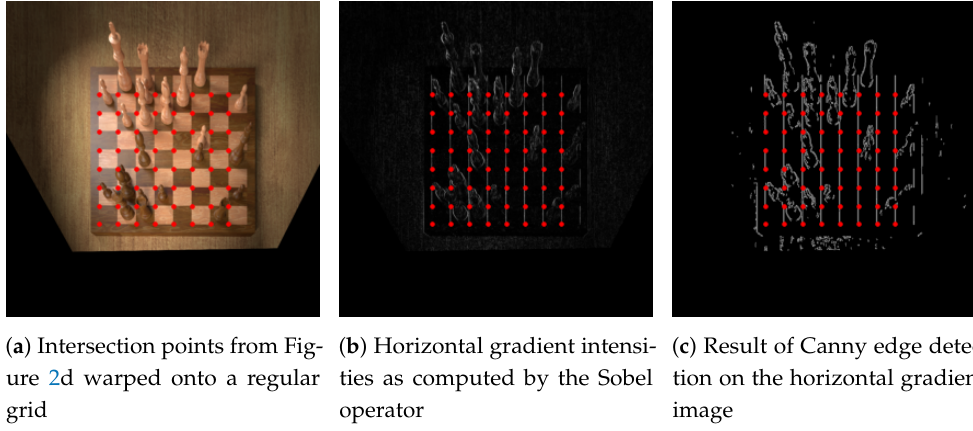
Figure 4. Horizontal gradient intensities calculated on the warped image in order to detect vertical lines. The red dots overlaid on each image correspond to the intersection points found previously. Here, x max − x min = 7 because there are eight columns of points instead of nine (similarly, the topmost horizontal line will be corrected by looking at the vertical gradient